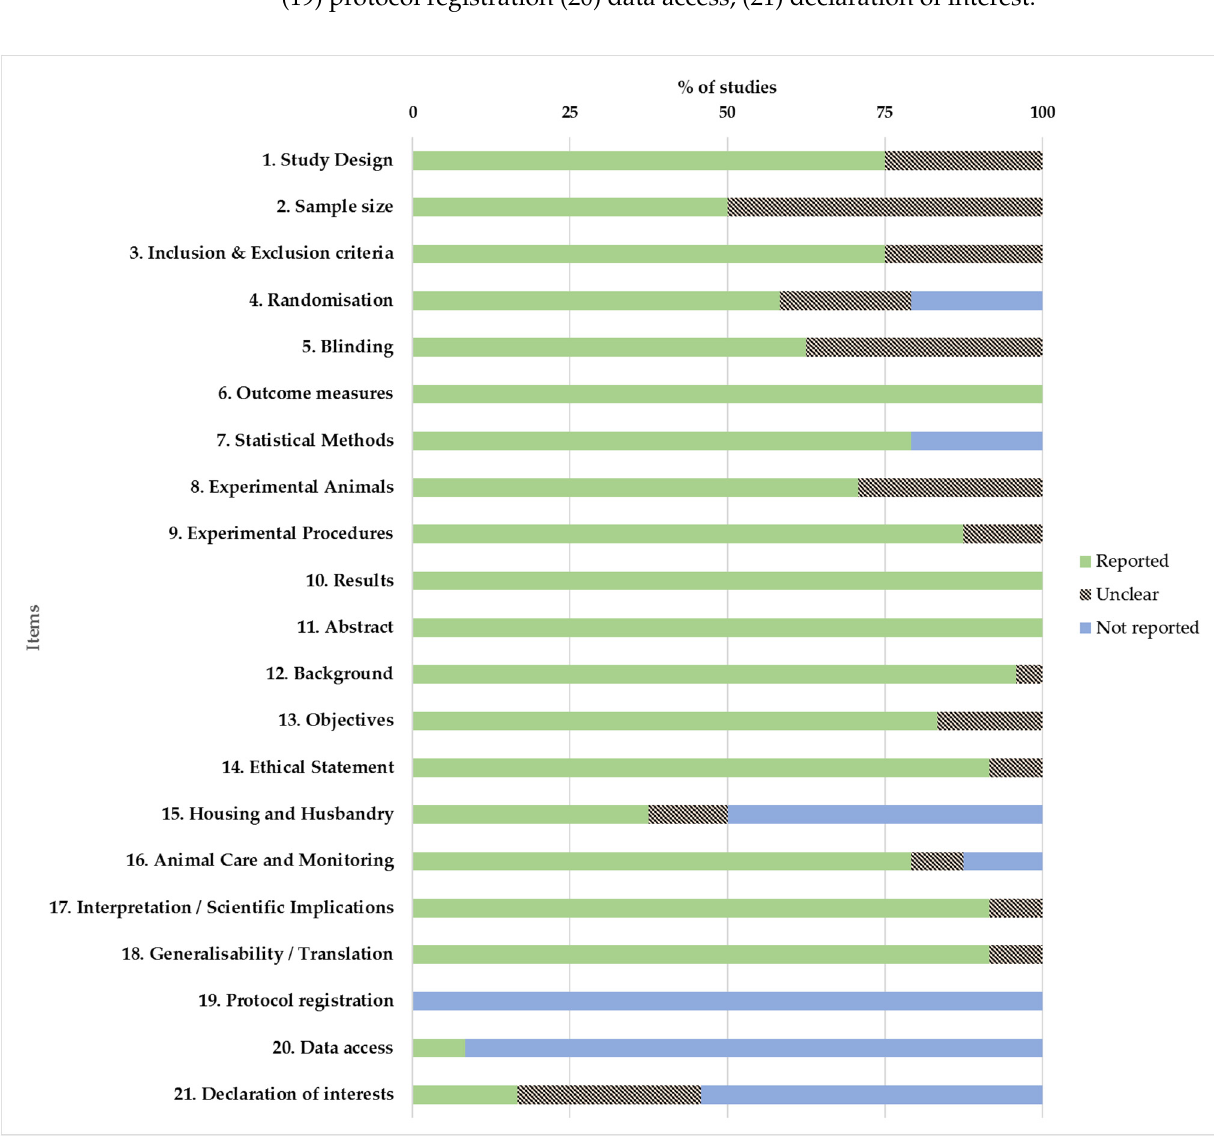
Figure 2. Quality assessments of the studies according to ARRIVE 2.0 guidelines. Values are expressed by % .